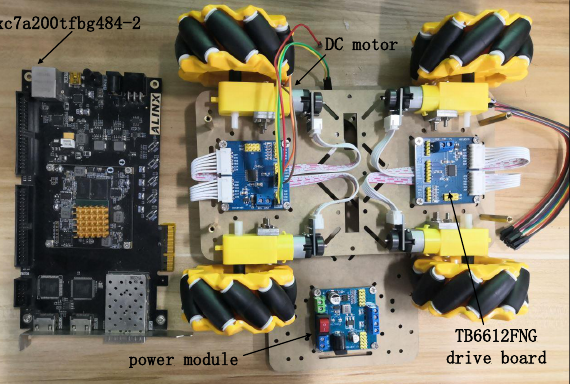
Figure 23. Experimental development platform for FPGA-based closed-loop control system.